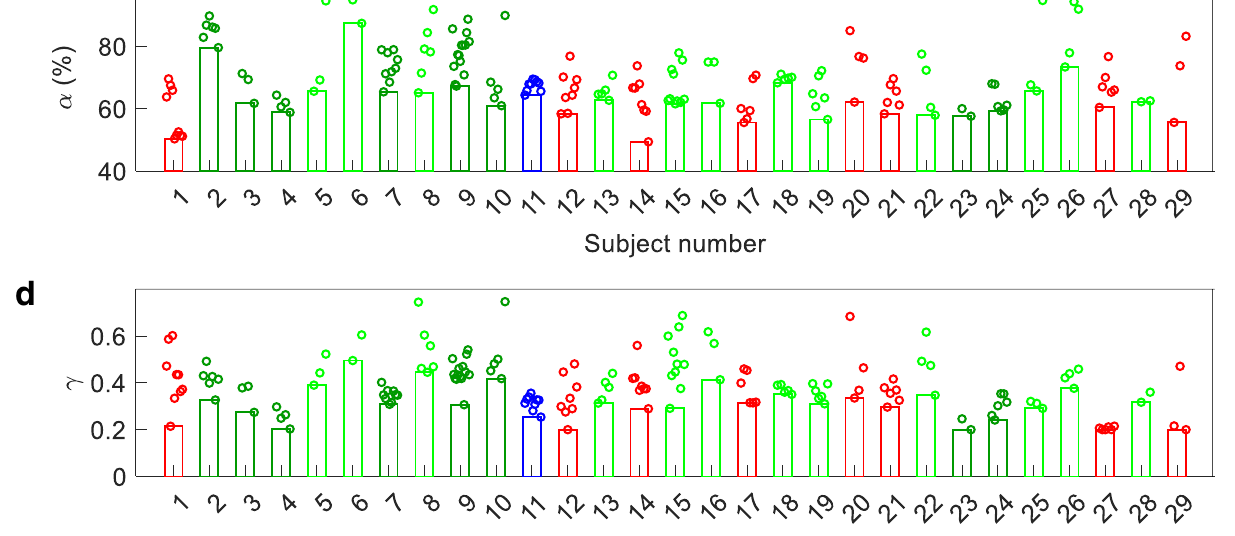
highest LSS-based diagnostic parameter Δ ( a ), hemoglobin concentration c Hb ( b ), lowest oxygen saturation α ( c ), and DRS-based scattering power γ ( d ) among all measurement sites of each subject. The red line at 0.2 in ( a ) represents the high- grade dysplasia and cancer diagnostic cutoff established earlier in pancreatic cysts 33